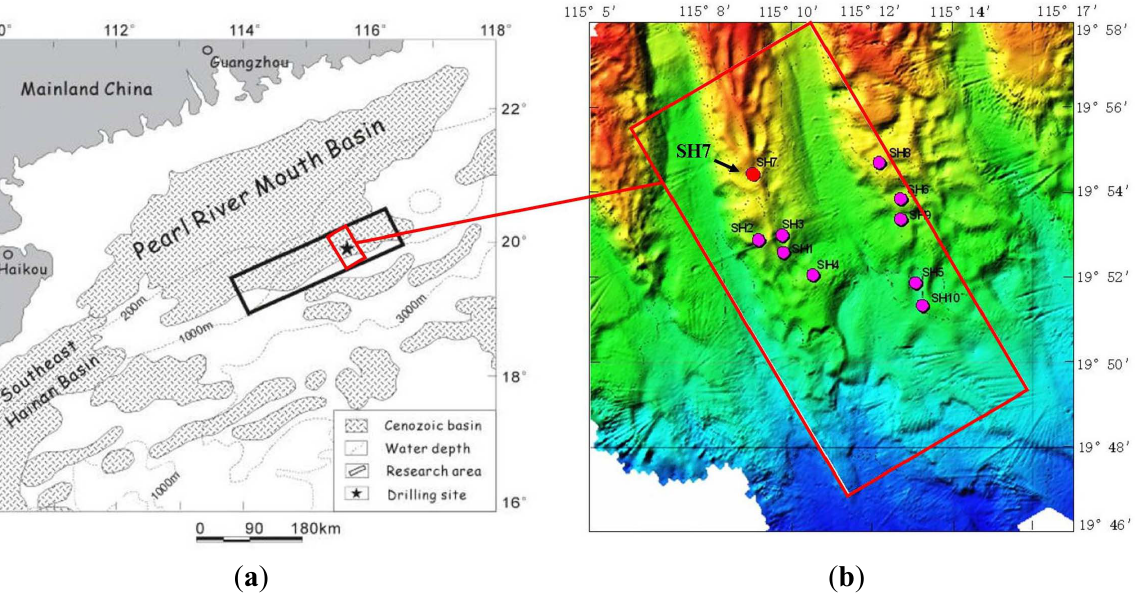
Figure 1. ( a ) Location of research area, Shenhu Area, north slope of South China Sea; ( b ) Bathymetric map of gas hydrate drilling area with sites drilled in the research area.